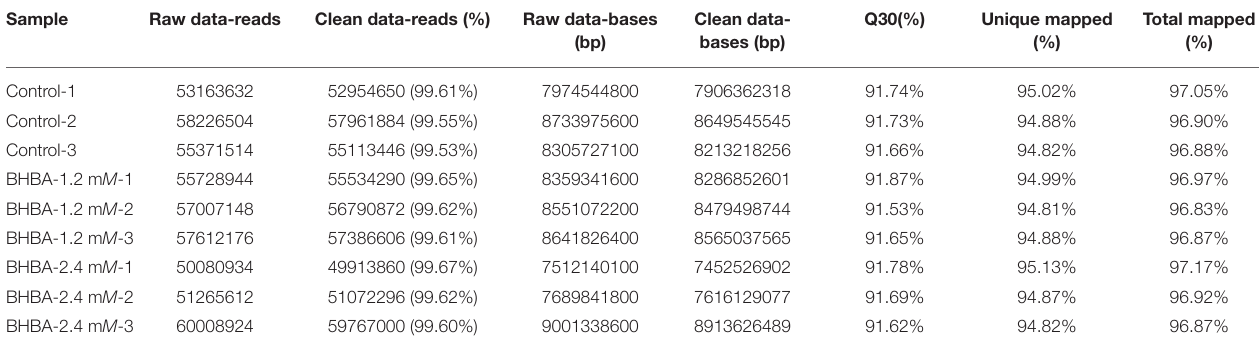
TABLE 2 | RNA-seq data quality analysis.